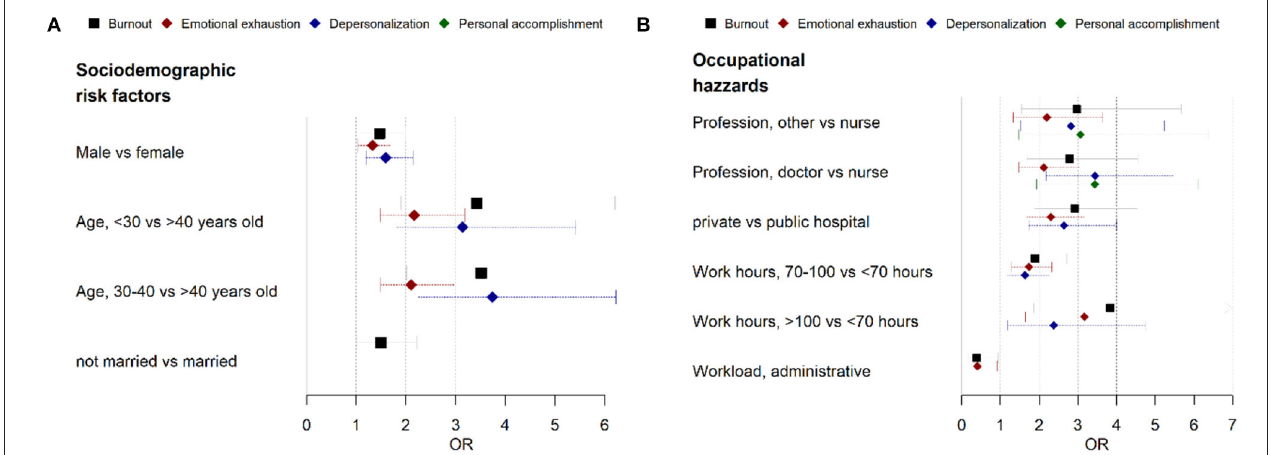
FIGURE 1 | A logistic regression plot of odds ratio ( OR ) and 95% confidence interval ( CI ) of the burnout subscale and the associated factors. (A) Sociodemographic factors and (B) occupational